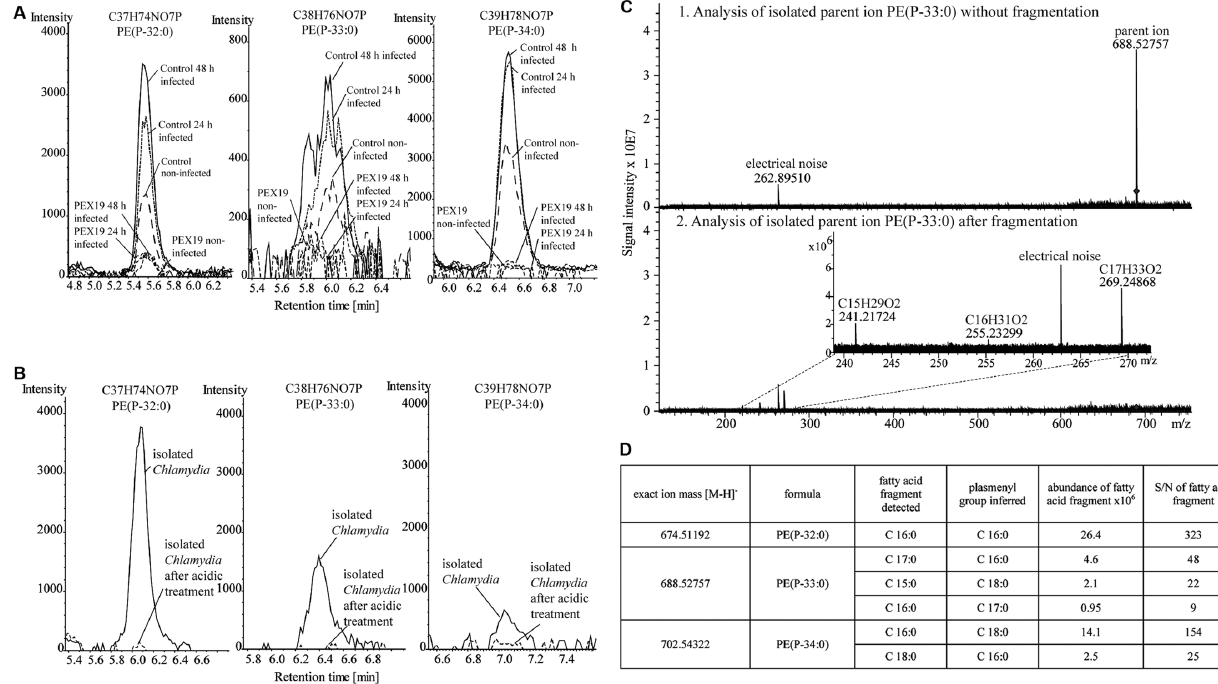
Figure 5. C.trachomatis contain bacteria-specific plasmalogens. A- Plasmalogens that increase in infected cells. Extracted ion chromatograms of plasmalogens of control and peroxisome-deficient (‘‘PEX19’’) fibroblasts, analyzed with RP LC-MS. The peaks of plasmalogens that increased upon 24 and 48 h of infection in control cells are shown. Notation, e.g. for PE(P-32:0): PE(P=plasmalogen version of phosphatidylethanolamine; 32:0=32 carbons in the combined side chains and 0 double bonds in the fatty acid. B- Plasmalogens in C. trachomatis . Phospholipids extracted from bacteria purified on a density gradient were analyzed as in B, with or without prior acid hydrolysis. The peaks with the same masses as in Panel B are shown. C- High resolution analysis and fragmentation of the plasmalogens of Panel C by SORI ICR/FT-MS 2 . The fragmentation pattern of PE(P-33:0) is shown as an example. D- Plasmalogen structures of C. trachomatis . Detected fatty acids and inferred structures for the Chlamydia -derived plasmalogens. S/N: signal to noise ratio.